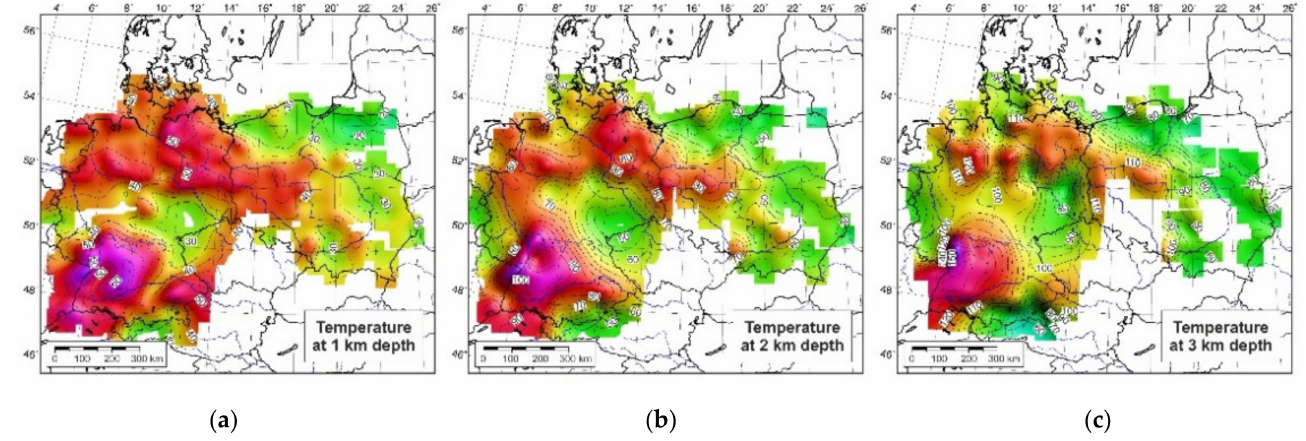
Figure 13. Compilation of temperature at depth ( a ) 1 km, ( b ) 2 km and ( c ) 3 km depth